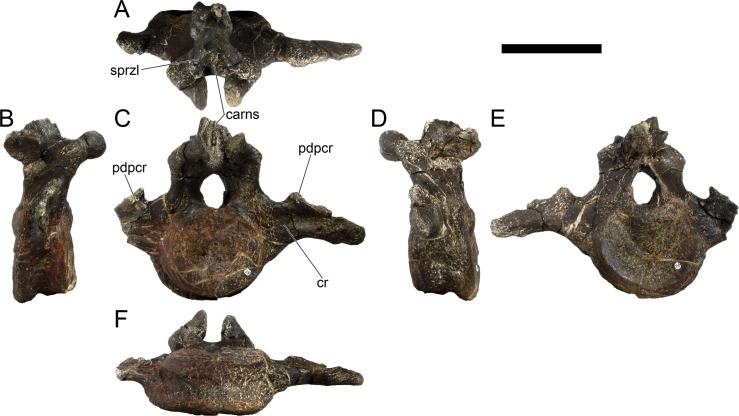
Caudal vertebra two of Miragaia longicollum MG 4863.A, dorsal, B, right lateral, C, anterior, D, left lateral, E, posterior, and F, ventral view. Carns, central anterior ridge of neural spine, cr, caudal rib, pdpcr, proximodorsal process of caudal rib, sprzl, spinoprezygapophyseal lamina. Scale bar equal to 10 cm.